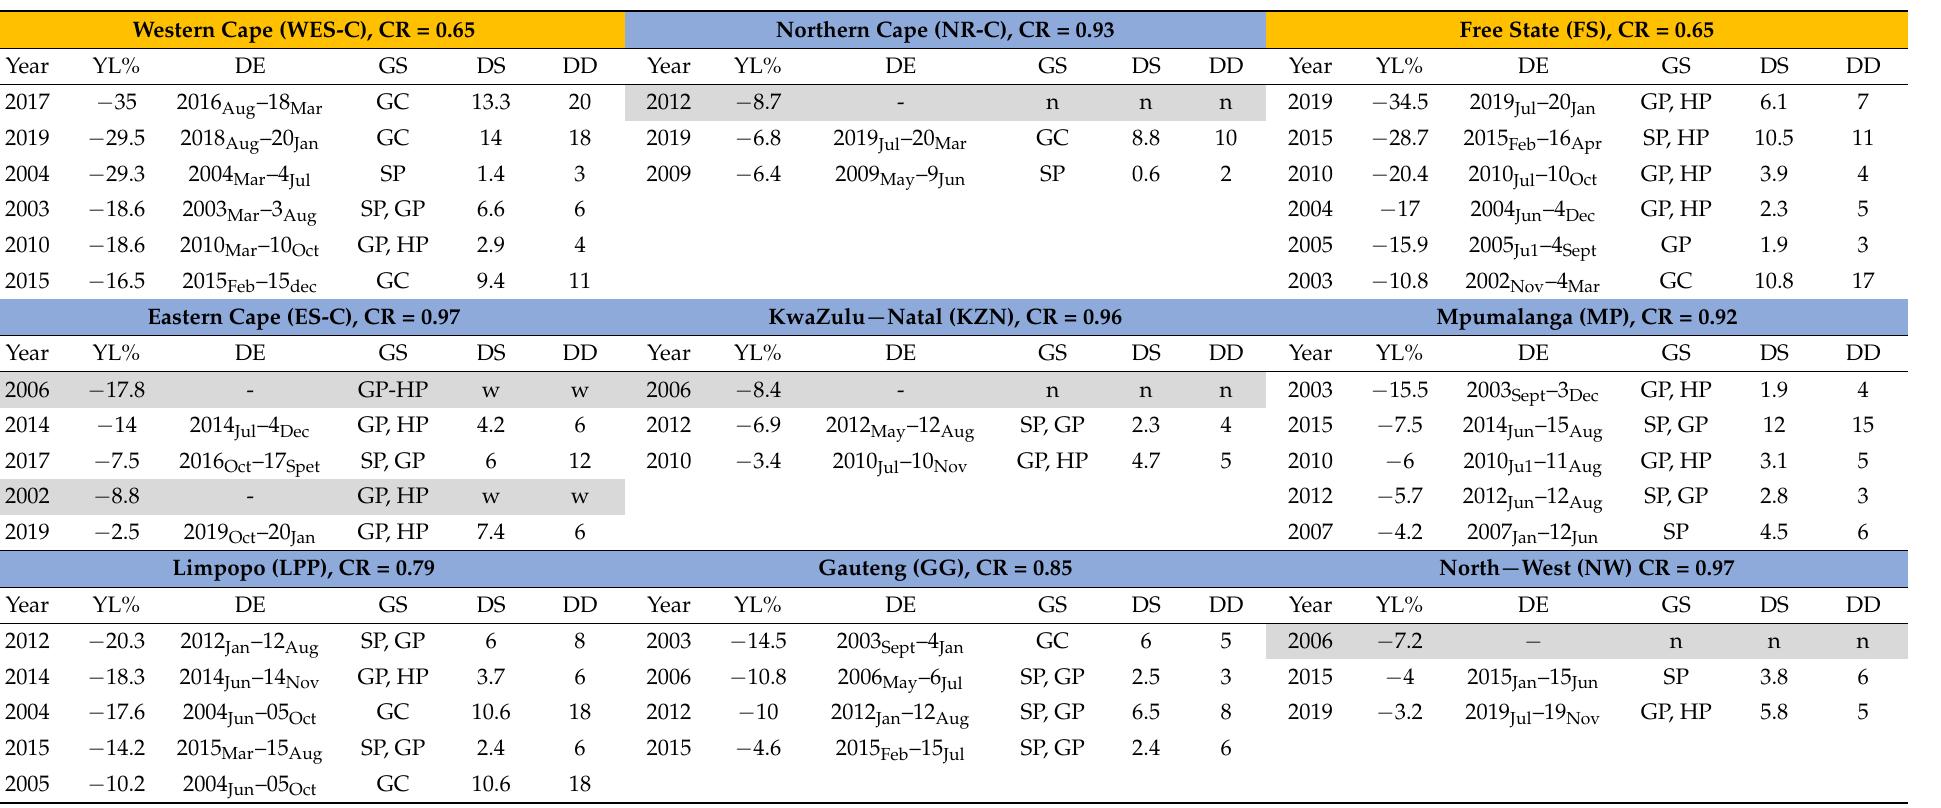
Table 7. Shows the percentage of wheat yield losses (YLs, %) caused by drought occurrences (drought event, DE) at the provincial level over a 3-month time scale during the winter wheat stages *. Western Cape (WES-C), CR = 0.65 Northern Cape (NR-C), CR = 0.93 Free State (FS), CR = 0.65